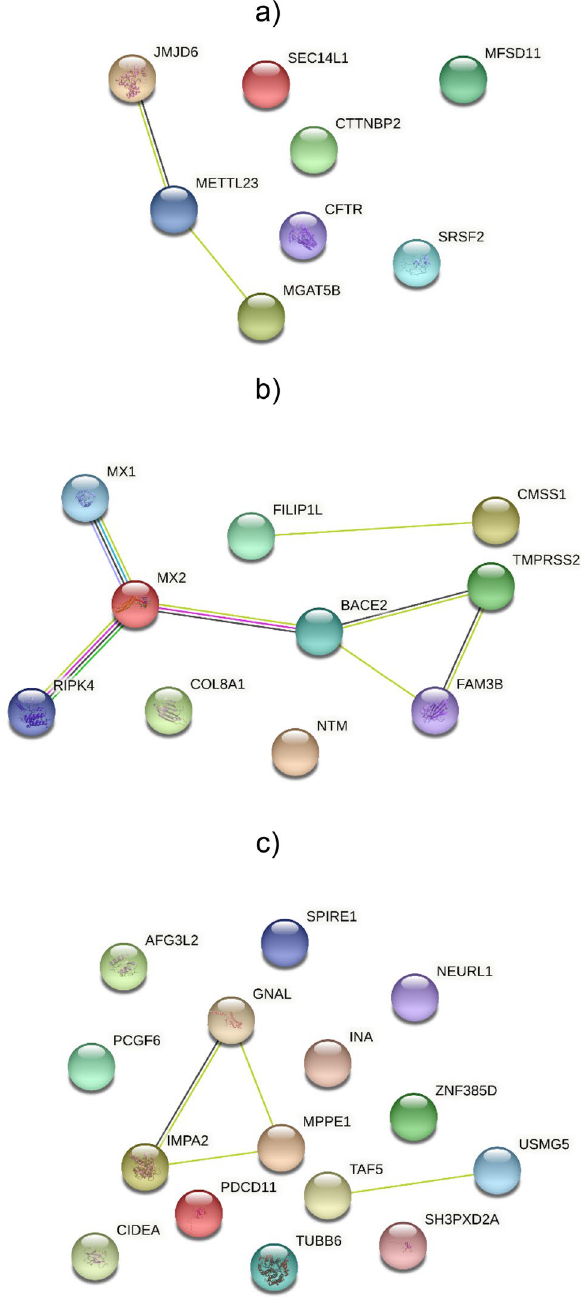
Figure 4. Protein networks of GWAS genes according to STRING database. ( a ) Pseudorabies; ( b ) Brucella; ( c ) Leptospira. Nodes are proteins; lines indicate interactions between proteins with: pink lines for known interactions experimentally determined, sea blue for interactions derived by curated databases. For the predicted interactions, green is for neighbourhood gene, red lines for gene fusions and blue lines for gene co-occurrence. Black lines are for co-expression, light green lines for text mining and light blue lines for protein homology. Protein interactions include direct (physical) and indirect (functional) associations derived from different sources (genomic context, high through-put experiments, conserved co-expression, previous